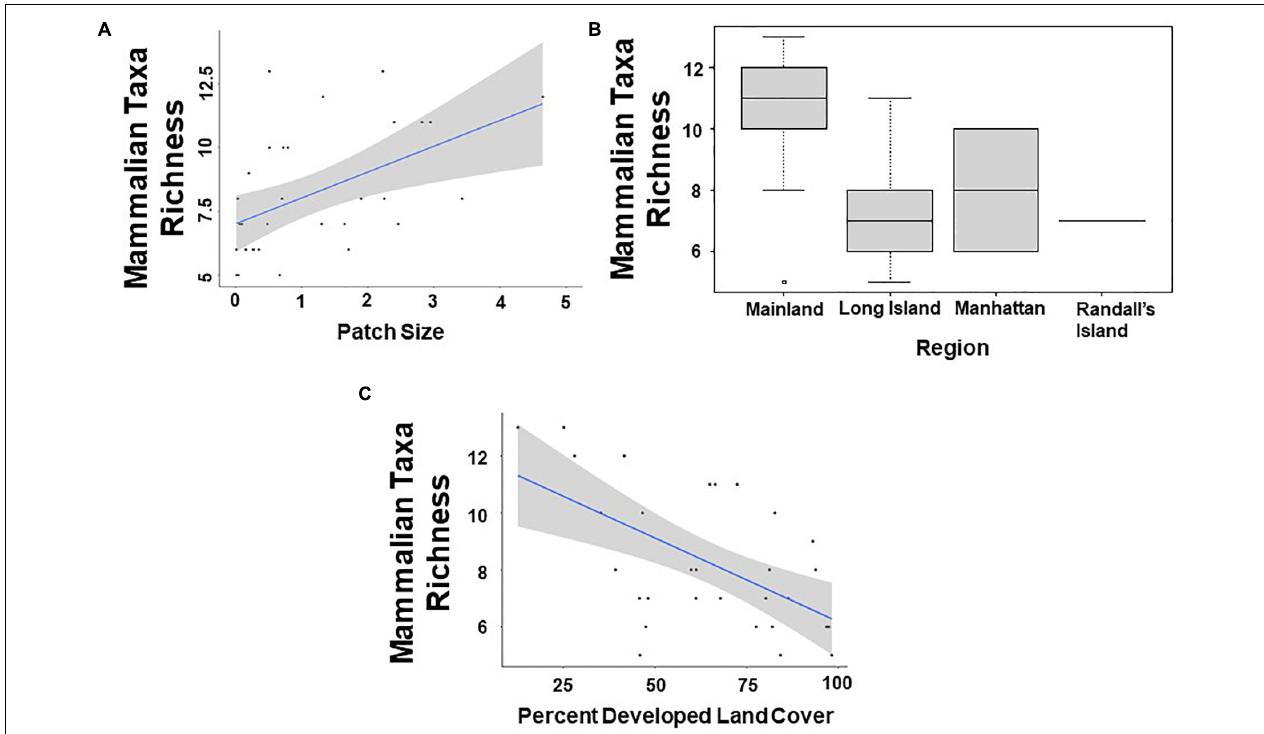
FIGURE 2 | Patterns among mammalian taxa richness and (A) patch size (km 2 ); (B) region; and (C) percent developed land cover (1,000 m scale) surrounding the 31 study sites.